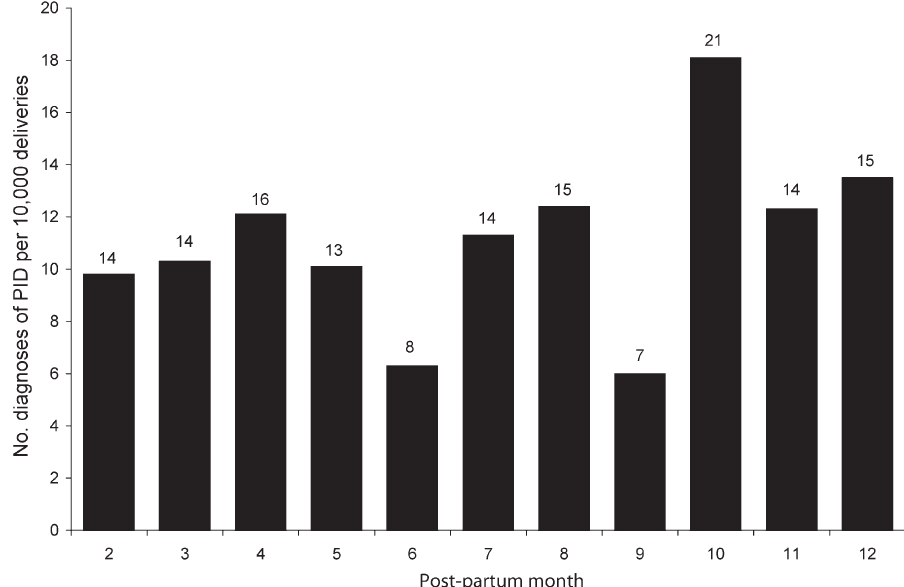
Figure 1. Incidence rate (bar) and number (above bar) by post-partum month of episodes of PID diagnosed during the post-partum year (excluding the first post-partum